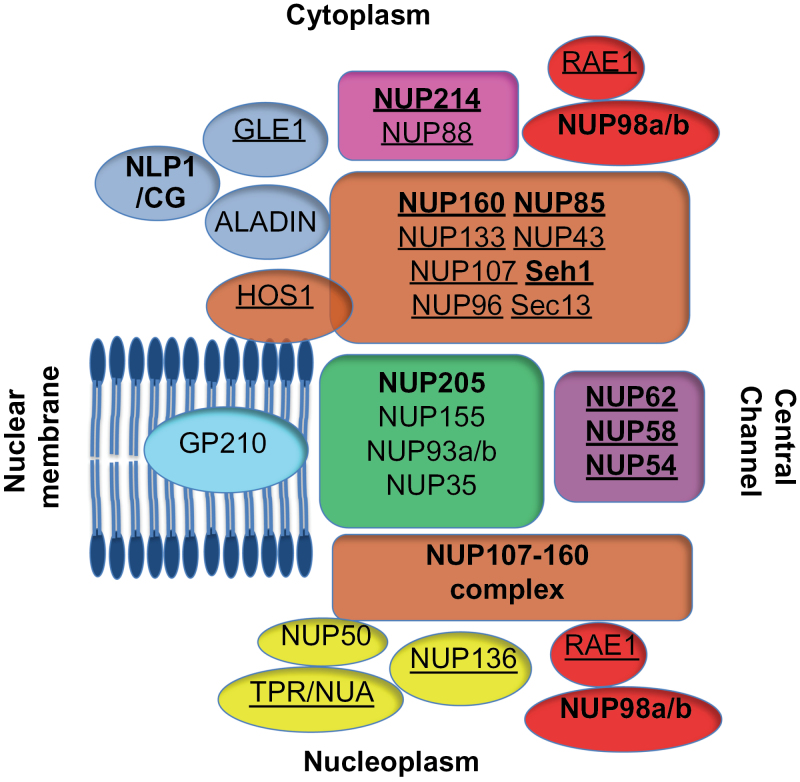
The Arabidopsis nuclear pore complex. Schematic of putative Arabidopsis nucleoporins identified during a previous proteomic screen. Nuclear pore subcomplexes are designated in colours taken from that study (Tamura et al., 2010). Nucleoporins in bold are studied herein and the mutant phenotype of nucleoporins whose name is underlined have been previously published: NUP214, GLE1 (Braud et al., 2012), NUP88 (Cheng et al., 2009), RAE1 (Lee et al., 2009), NUP160 (Dong et al., 2006b
; Parry et al., 2006; Robles et al., 2012), HOS1 (Dong et al., 2006a
; Lazaro et al., 2012; Jung et al., 2013; MacGregor et al., 2013), NUP133, NUP107, NUP85, NUP43, Seh1, Sec13 (Wiermer et al., 2012), NUP96 (Zhang and Li, 2005; Parry et al., 2006), NUP62 (Zhao and Meier, 2011), NUP136/NUP1 (Lu et al., 2010; Tamura et al., 2010), and TPR/NUA (Jacob et al., 2007; Xu et al., 2007b
).